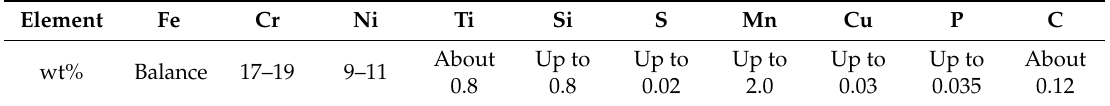
Table 3. Chemical composition of 12Kh18N10T steel (AISI 321) in wt%.